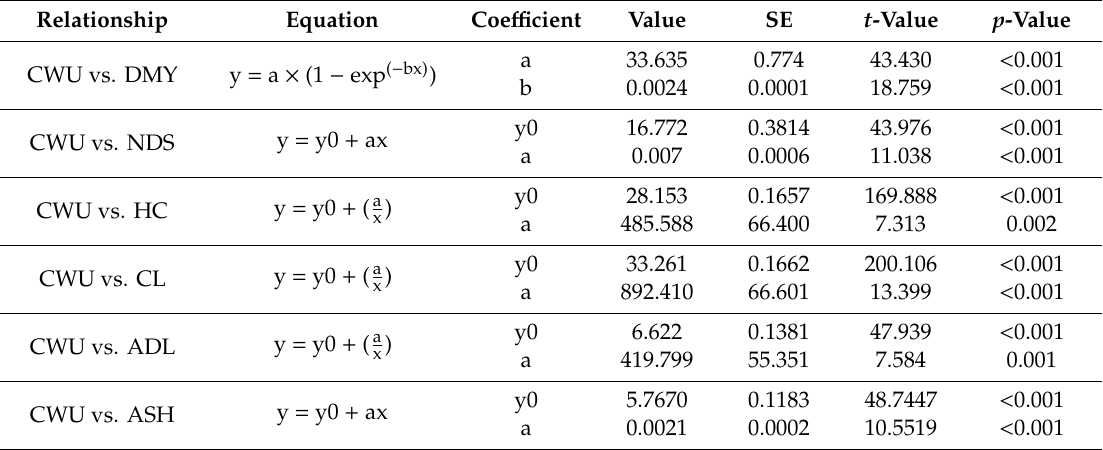
Table 3. Estimated coe ffi cients, standard error, t -and p -value of the fitted equations between crop water use and biomass yield and composition of Saccharum under changing irrigation and growing